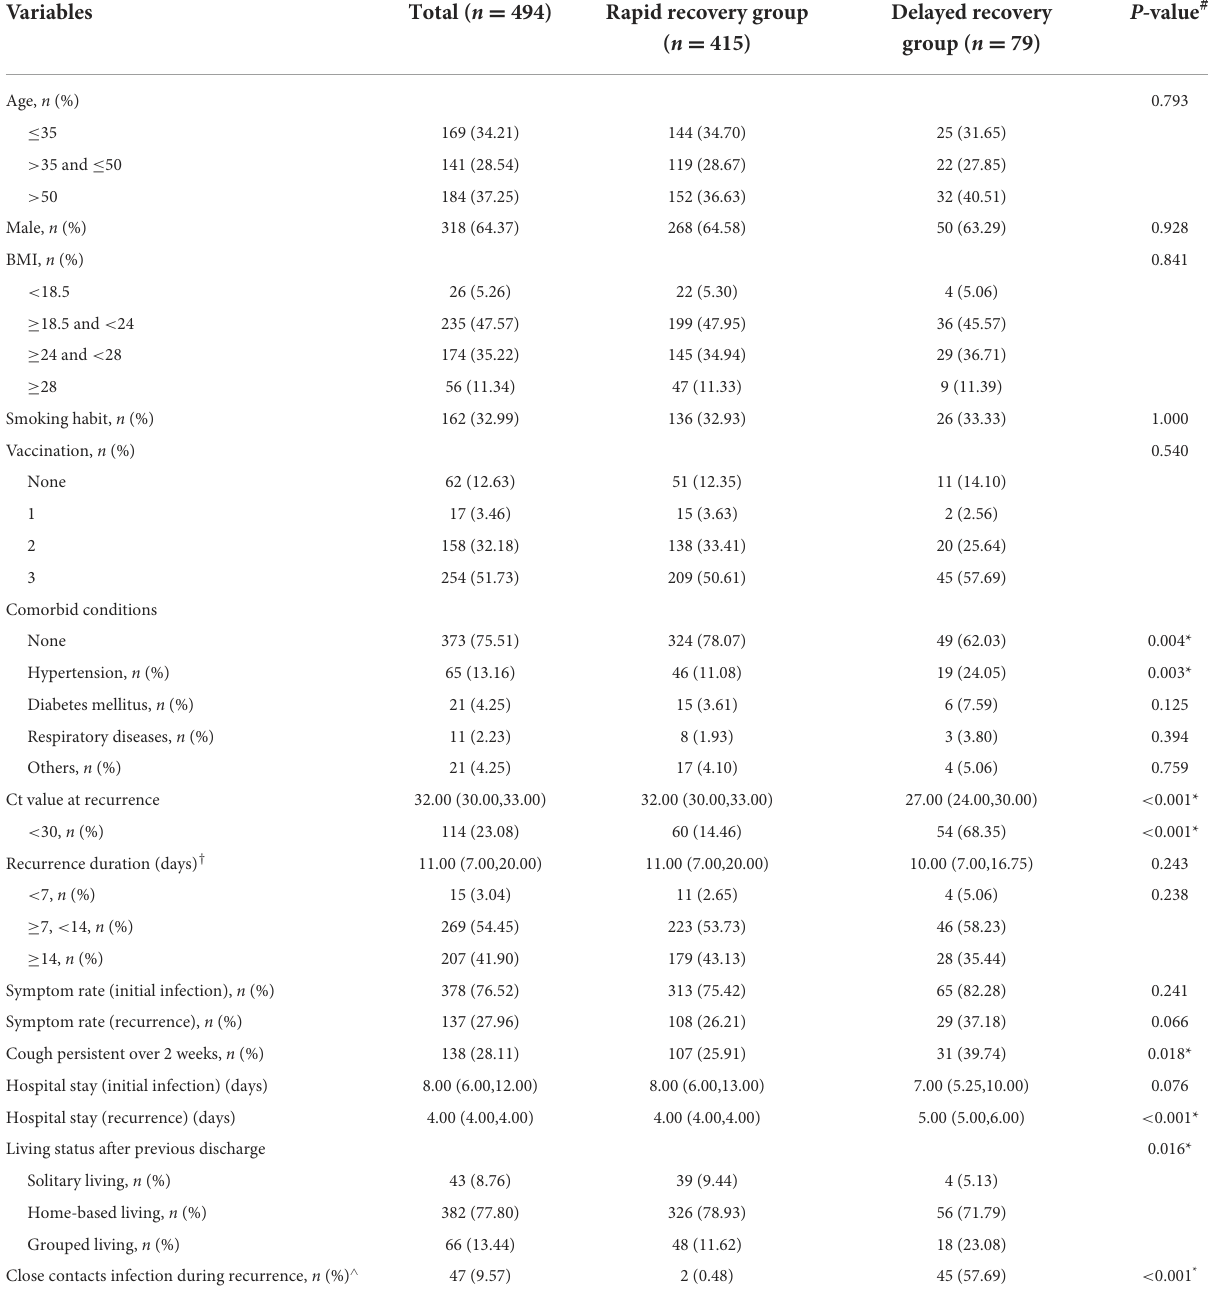
TABLE 1 Demographic and epidemiologic